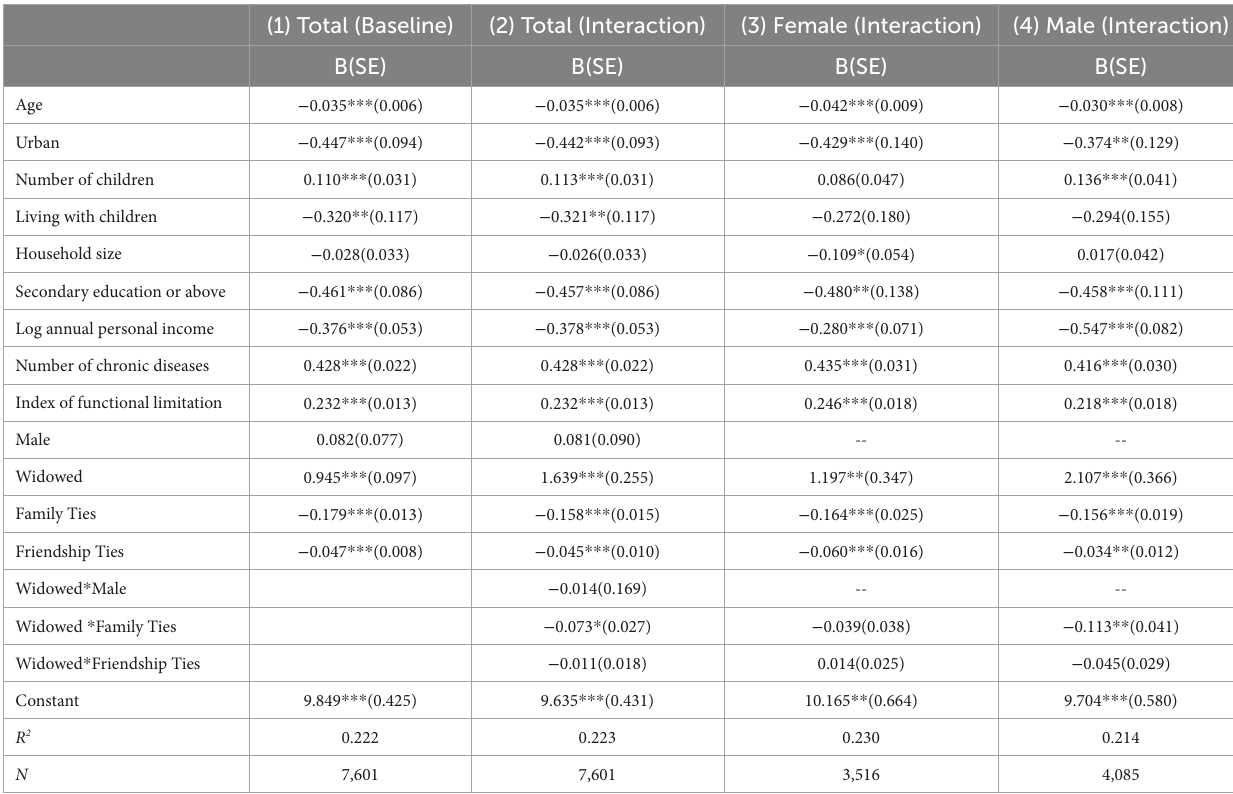
TABLE 3 Linear regression models predicting depressive symptoms of Chinese older adults: total sample, female and male